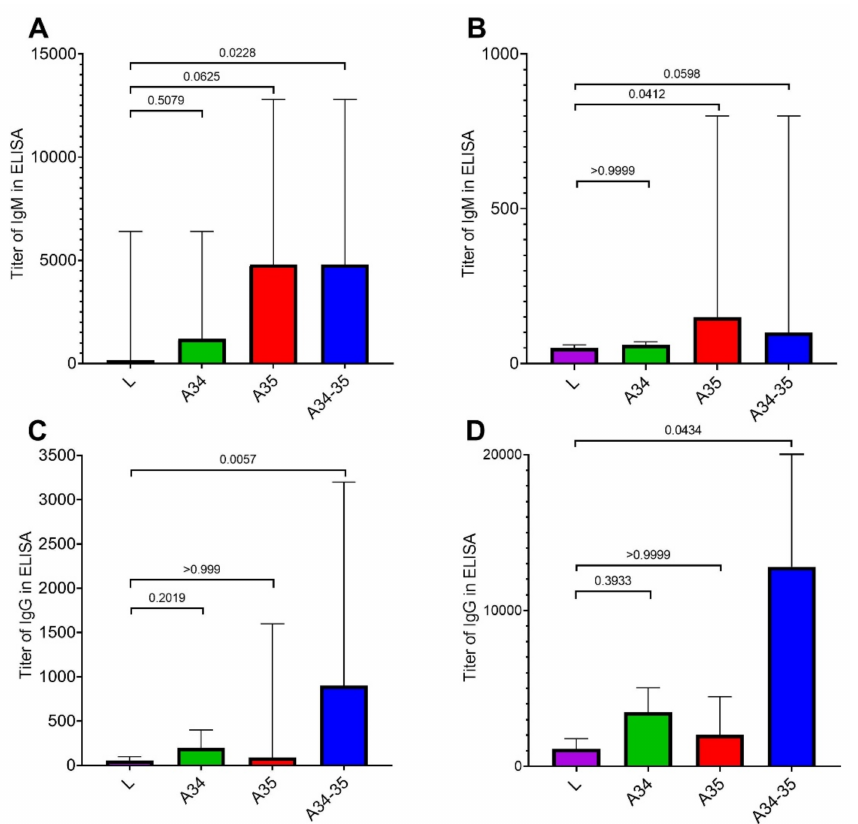
Figure 2. The VACV-specific humoral response in mice immunized with VACVs: L—the LIVP strain; A34—LIVP-A34R*; A35—LIVP-dA35R; and A34-35—LIVP-A34R*-dA35R. The reciprocal titers of virus-specific IgM on day 14 ( A ) and day 28 ( B ); the reciprocal titers of virus-specific IgG on day 14 ( C ) and day 28 ( D ) are given. The diagrams show the median values and the range. Statistical analysis was performed using the GraphPad Prism 9.0 software. Intergroup differences in immune responses were assessed with the non-parametric one-way Kruskal–Wallis analysis of variance adjusted for multiple comparisons used Dunn’s statistical hypothesis testing. The p values are indicated above the horizontal